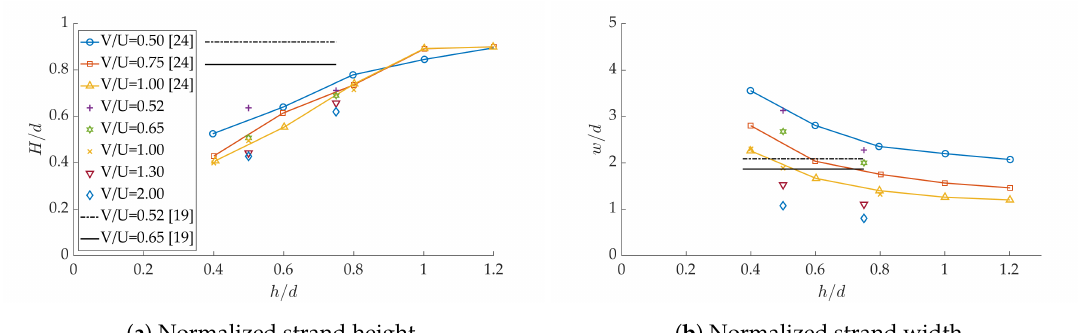
Figure 15. Comparison of strand dimensions with previous